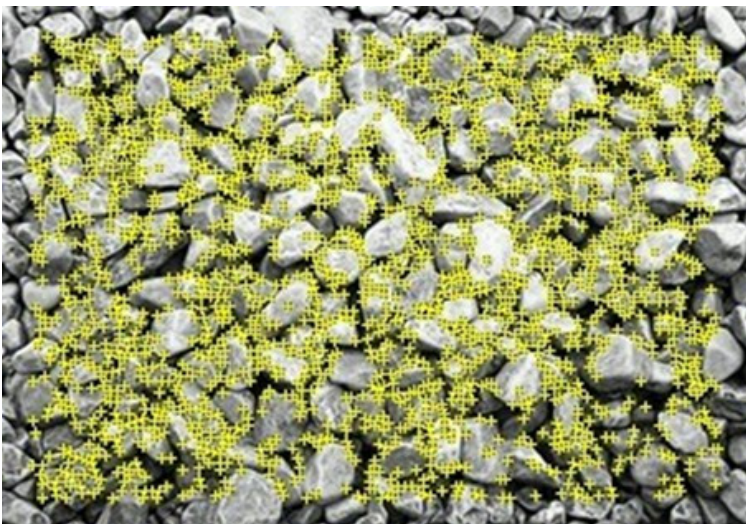
Figure 10. Different color representations of the car model.